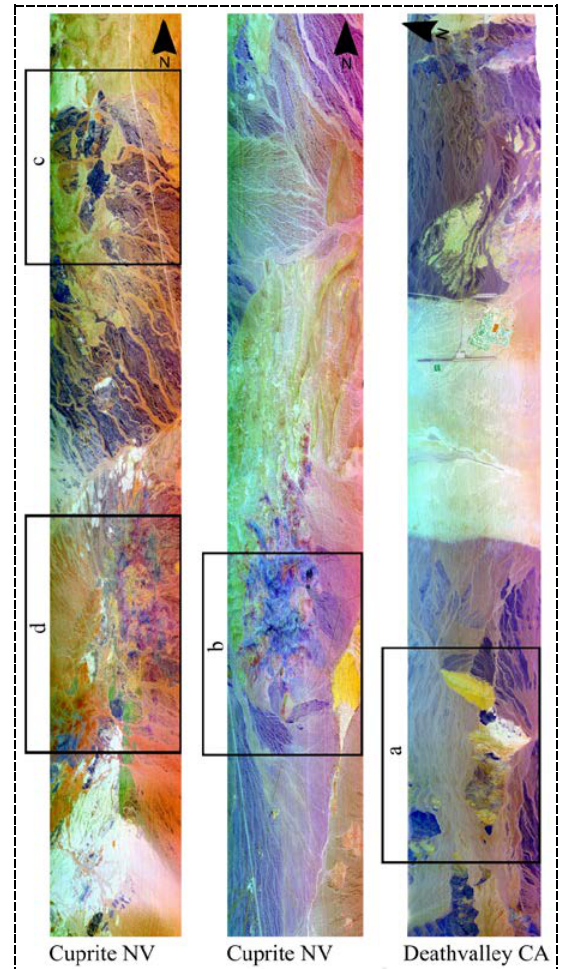
Figure 1. Study Areas